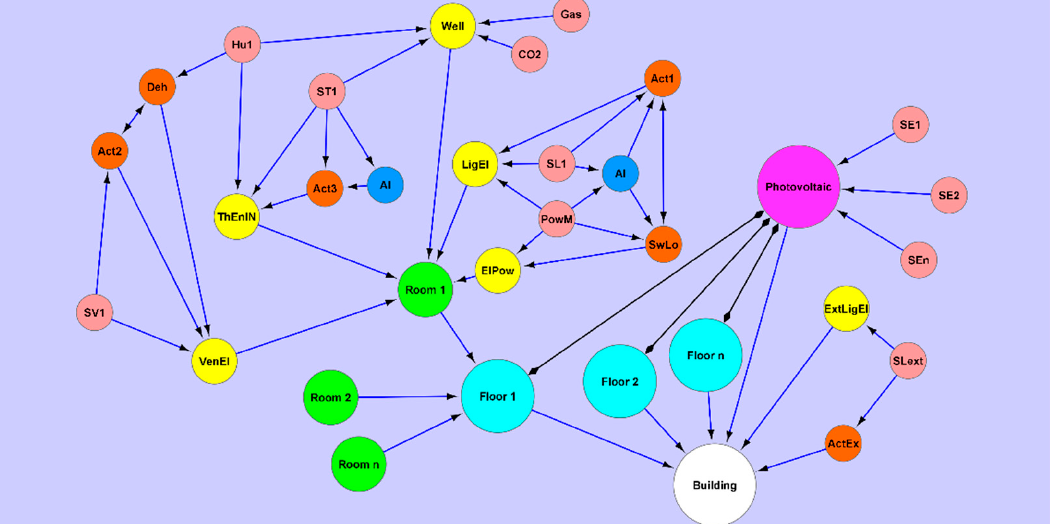
Figure A2. Complex architecture in smart building energy system. The graph model with linked nodes has been designed by means the open source Cytoscope tool.